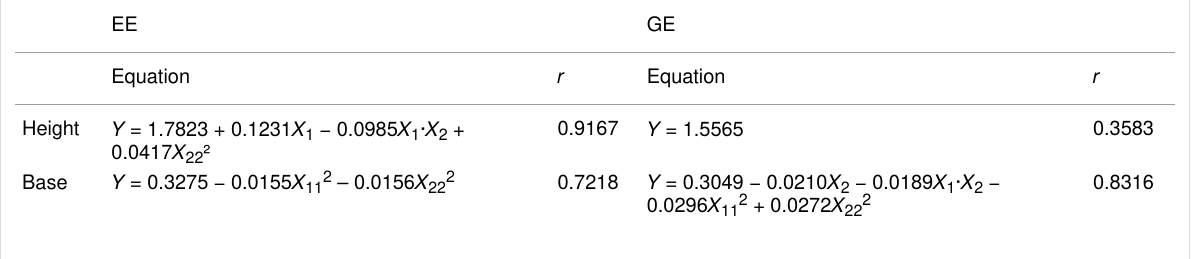
Table 2: Equations obtained for the height and base responses with the correlation coefficient r